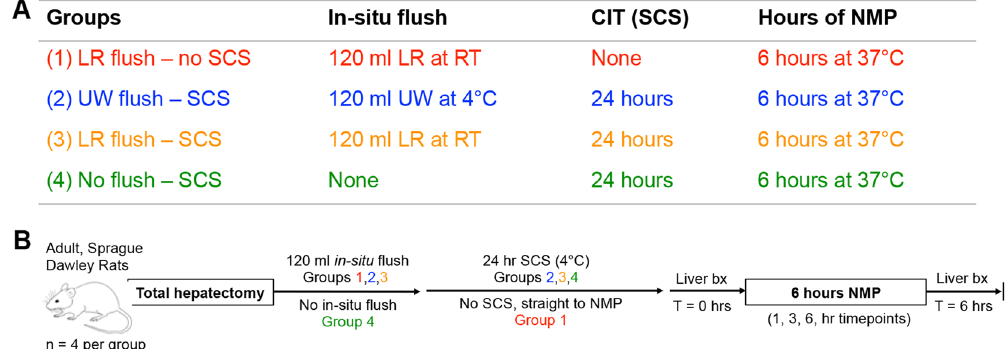
Figure 1. Experimental design. ( A ) Flush group designation (n = 4) and ( B ) experimental design. Each group of adult, Sprague Dawley rats underwent total hepatectomy with an in-situ flush (except group 4 which had no flush), following by 24 h of SCS (except group 1 which went straight to NMP). Liver biopsies for histology were taken prior to perfusion and after 6 h of perfusion, and perfusion metrics were recorded at 1, 3, and 6 h